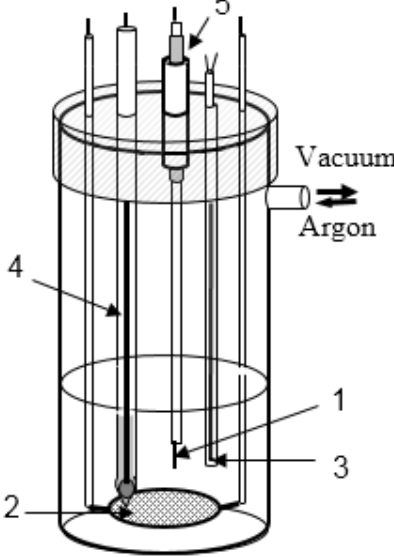
Figure 1. Electrochemical set-up. Working electrode ( 1 ), counter electrode ( 2 ), thermocouple ( 3 ), ref- erence electrode ( 4 ), glass joint ( 5